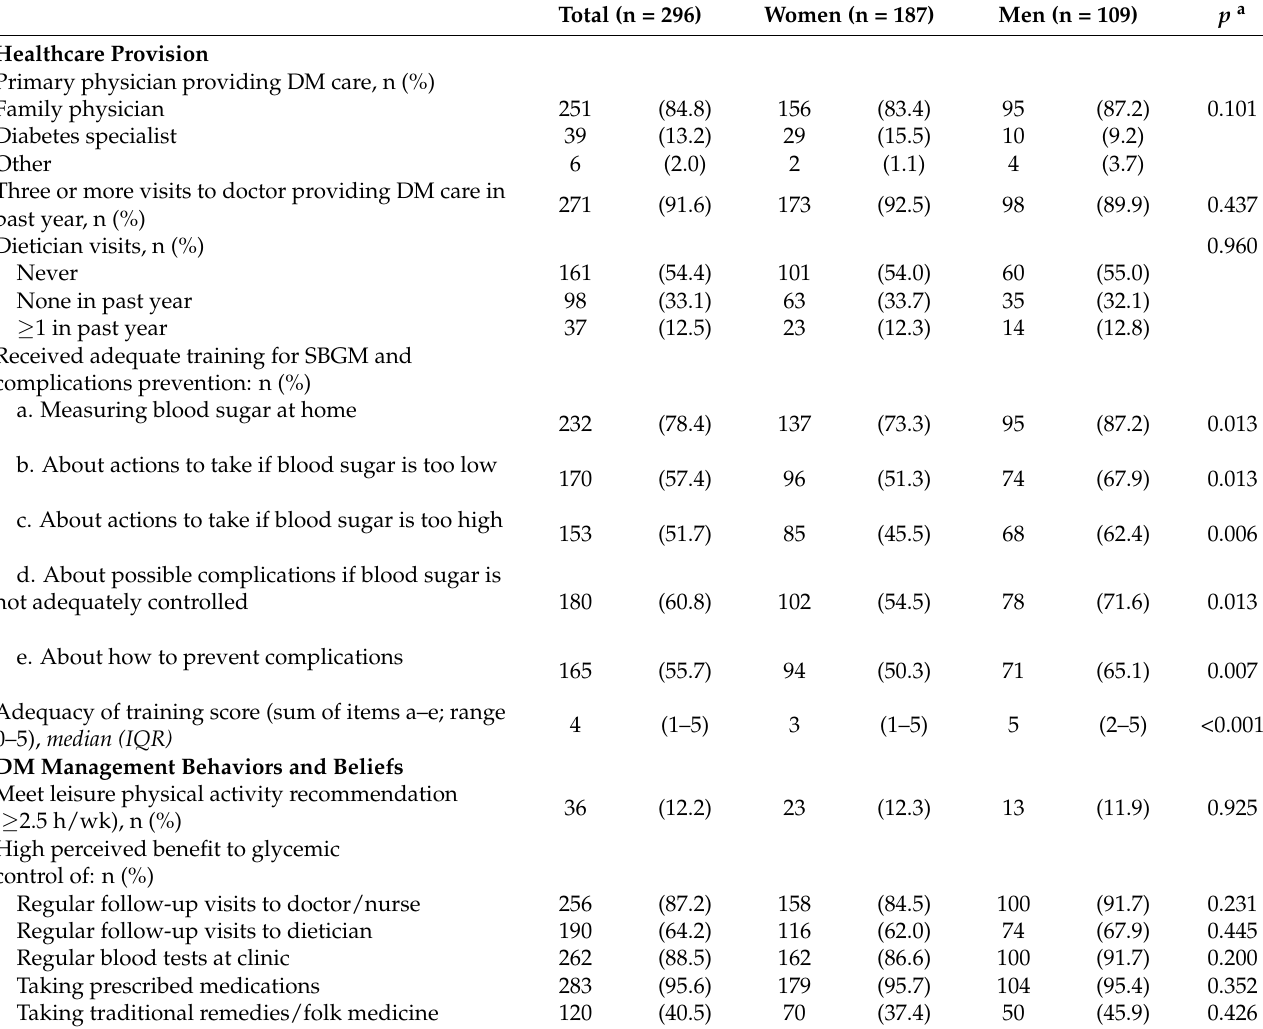
Table 2. The healthcare and self-care parameters, and perceptions of their adequacy/value among DAPI interview respondents by gender (n =